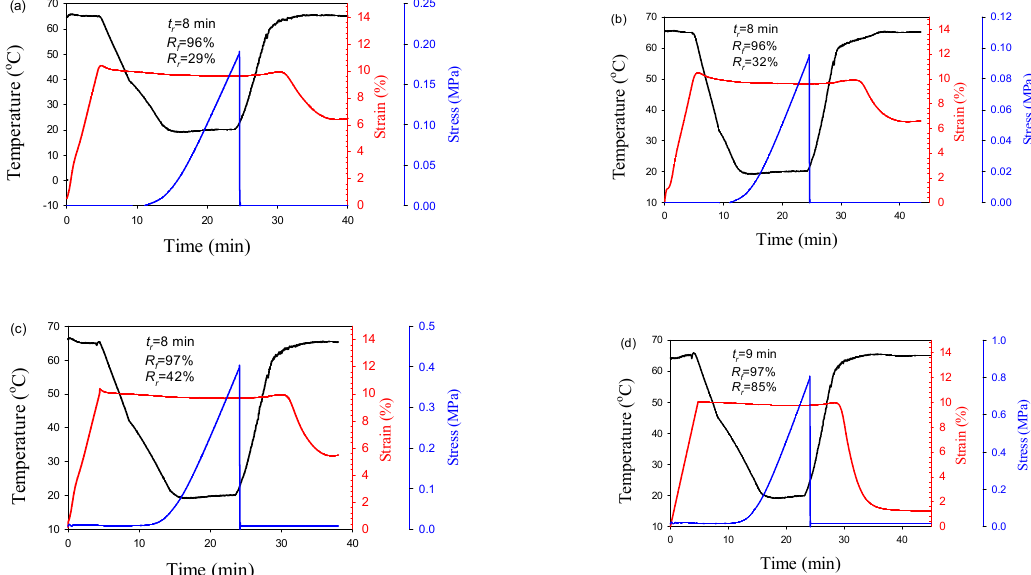
Figure 5. Temperature and strain of PLA/PBAT/CNFs blends ( a , b ) and in situ generated composites ( c , d ) during dual shape memory cycle. T d = 65 °C. ( a , c )–3%, ( b , d )–7 wt.%CNTs.